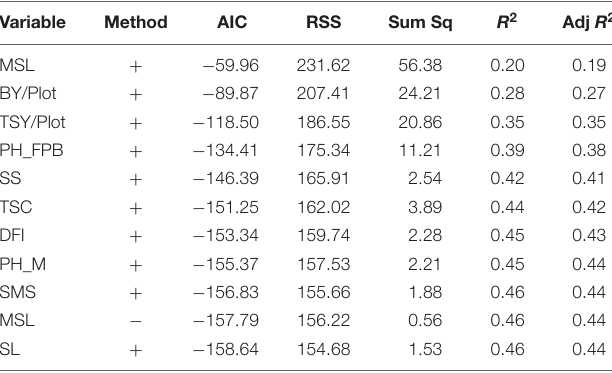
TABLE 3 | Summary of stepwise regression analysis considering seed yield per plant as a dependent variable to determine the significance and relative contribution of other traits under normal sown condition.